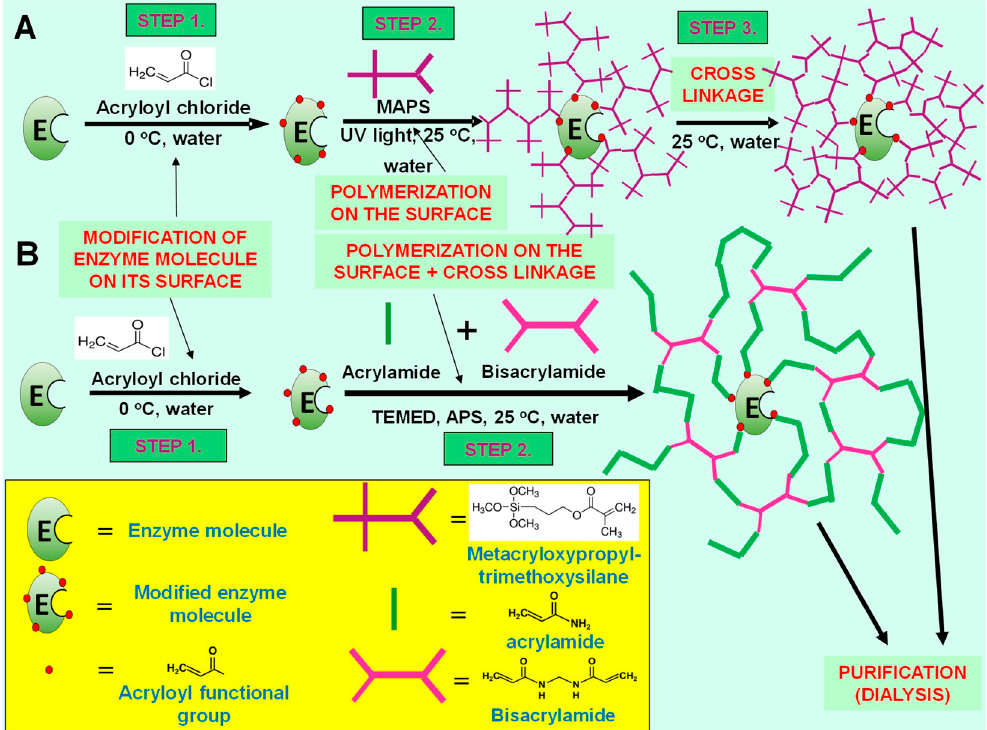
Figure 1. Synthesis methods and chemical structures of enzyme nanoparticles. Enzyme molecules are covered by a thin, porous polymer layer that allows the diffusion of substrate and product molecules and the intramolecular movements of molecules during the biocatalytic reaction. ( A ) Synthesis consisting of three main steps: surface modification (in water), polymerization from the surface of the enzyme (in n-hexane) and finally cross linkage between polymer fibers (in aqueous solvent). ( B ) Two-step (one-pot) synthesis of enzyme nanoparticles: modification and polymerization/cross linkage in aqueous solvent.